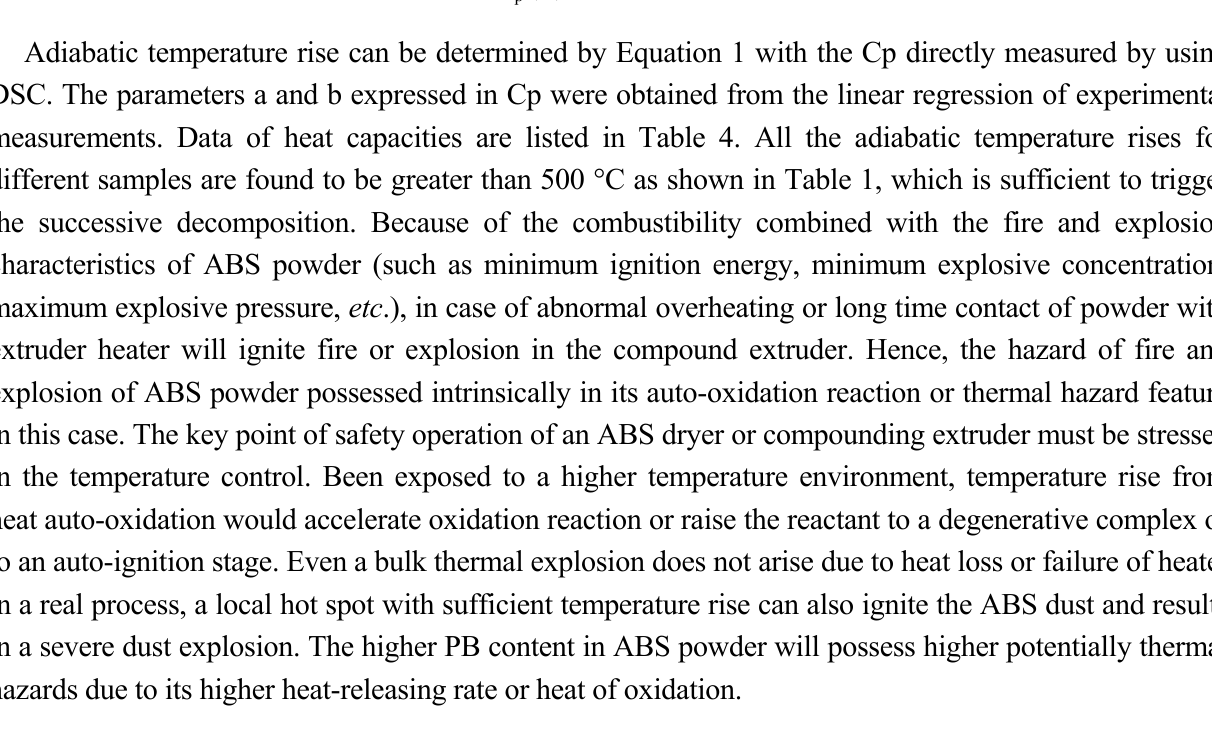
Table 4. Heat capacities of various ABS